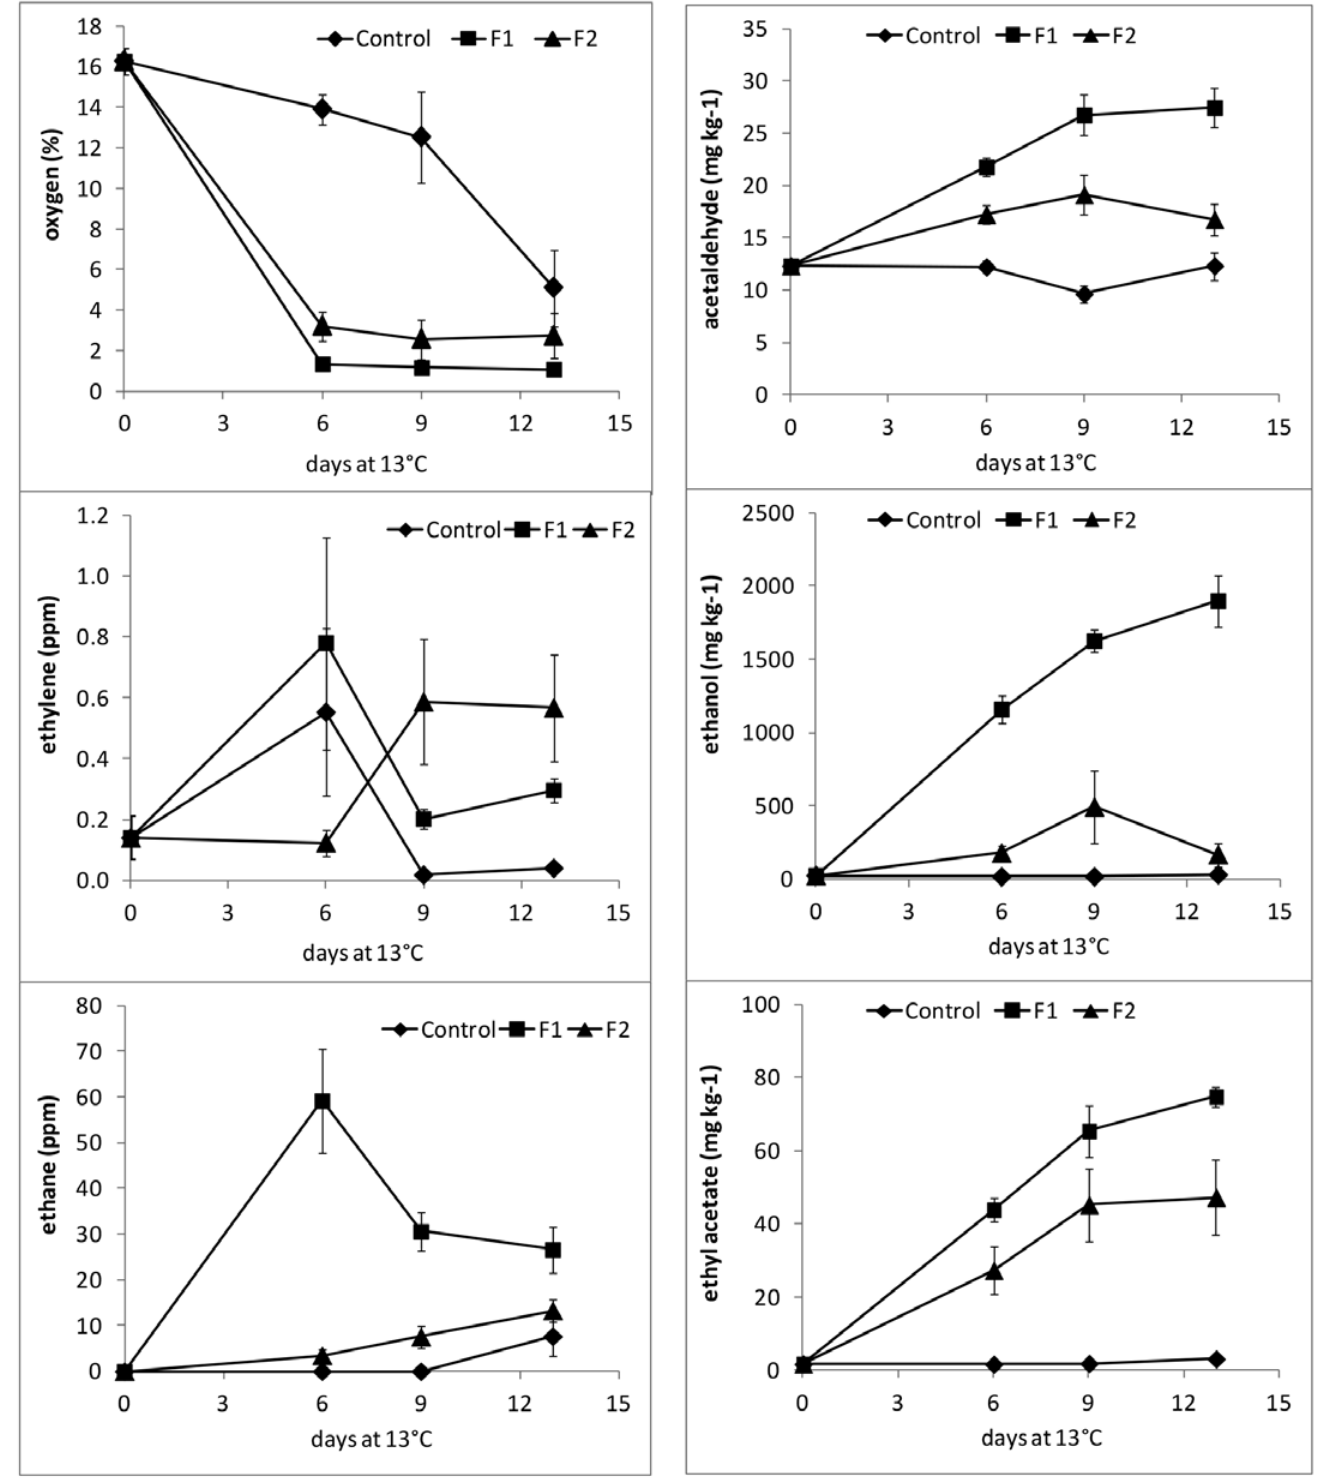
Fig. 1 - Internal oxygen, ethylene, and ethane concentrations (left) and fermentative metabolites (acetaldehyde, ethanol, ethyl acetate - right) amounts of control and coated (F1, F2) melon fruit during storage at 13°C. Bars refer to standard error of the mean